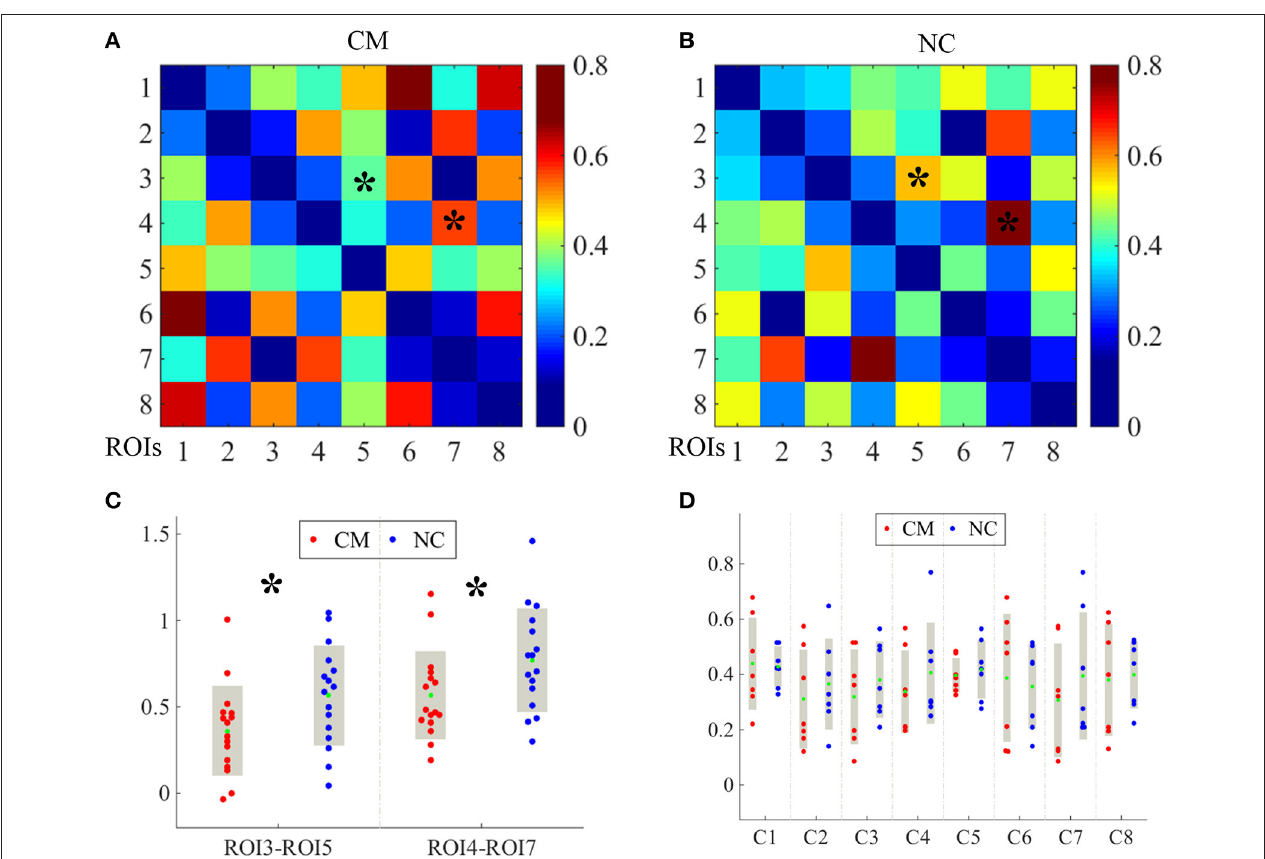
FIGURE 2 | The averaged region of interest (ROI)-based functional connectivity (FC) values after Fisher’s r-to-z transformation of CM and NC groups were shown as in image (A,B) , respectively. Each cluster was taken as one ROI for FC computation. The FC values between C3 and C5, and FC values between C4 and C7 [indicating by * in image (A,B) ] were significantly altered between CM and NC. The significantly reduced FC values were presented in image (C) . The FC values between all 8 clusters of CM (red dots) and NC (blue dots) (D) . The green dots indicate mean FC values. * p <